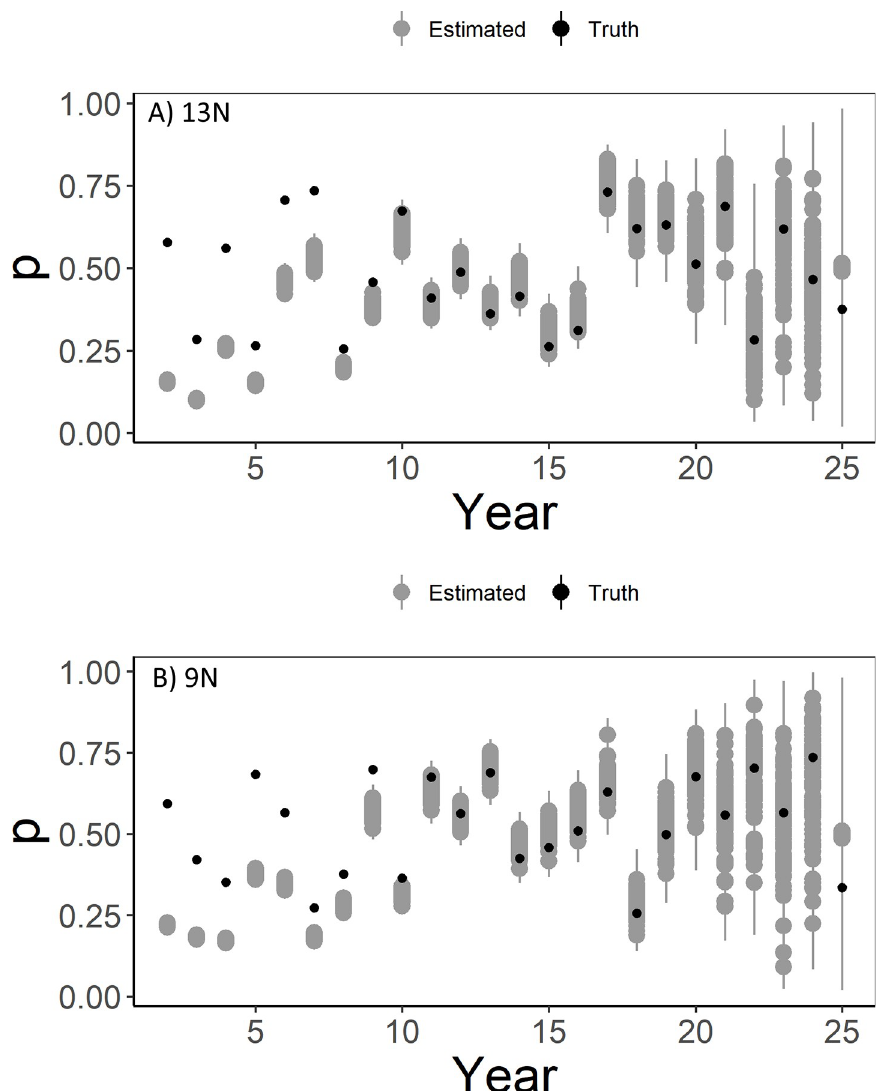
Fig 6. Detection probability estimates from models with density-based lek attendance. Detection probability estimates (“Estimated” in gray) of lesser prairie-chickens from an N-mixture model with density-based lek attendance (A, Scenario 13N) and without (B, Scenario 9N) and random detection probability. True values of detection probability are shown in black (“Truth”). Points represent mean or true values from each simulation and whiskers represent 95% quantiles for each